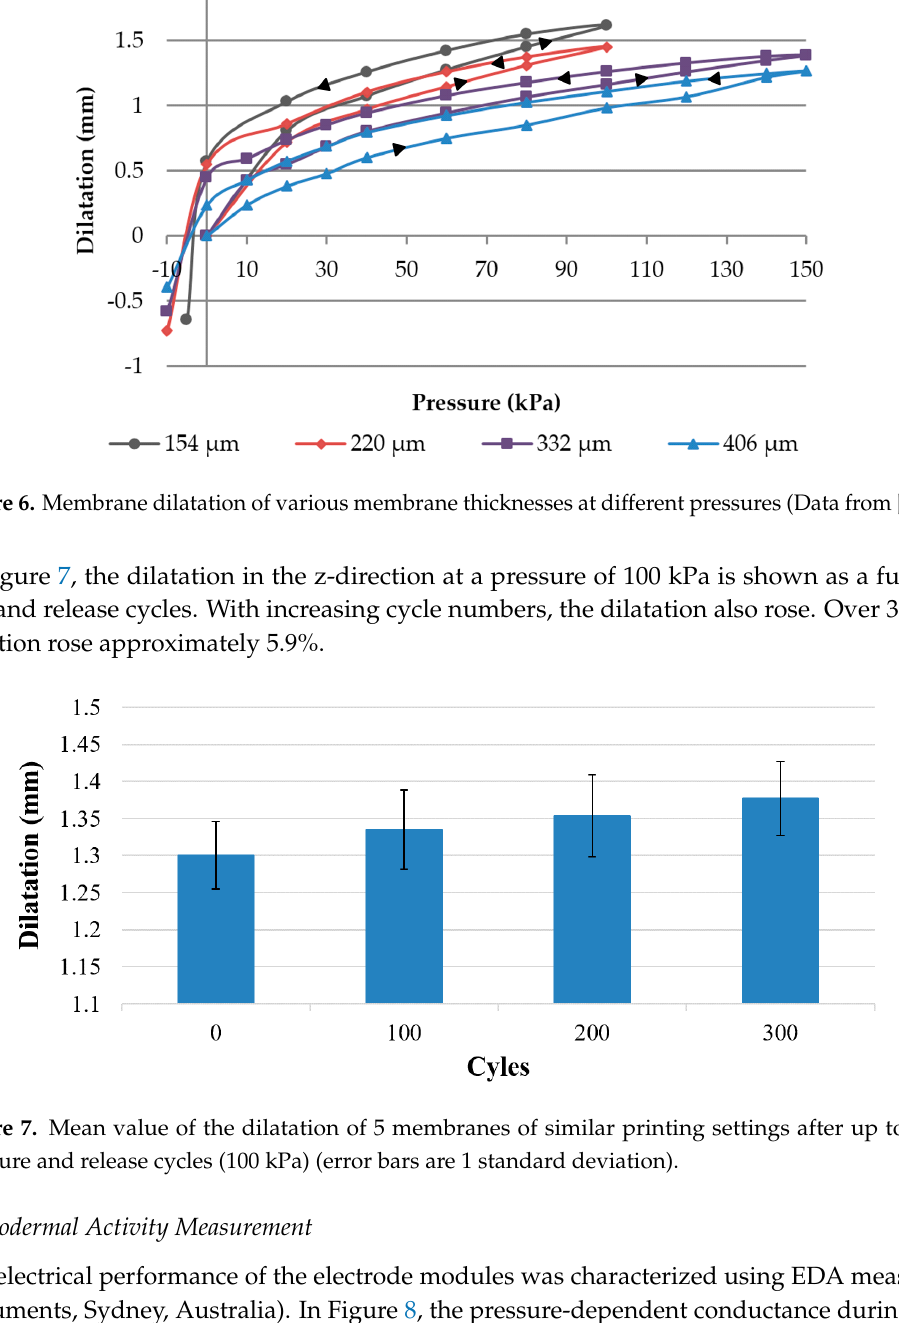
Figure 8. Pressure-dependent conductance on skin of the screen-printed electrode module on one subject (Data from [21]). Figure 9 shows the EDA measurements for each type of electrode, averaged over all 5 subjects. The finger electrode showed highest conductivity, because fingers and palms contain a higher density of sweat glands compared to the forearm, and the electrode area was the largest. Taking into account that the stainless steel electrode, with the second-largest electrode area, showed the second-highest conductivity, the achieved results are reasonable. The electrode modules both showed lower conductivity in comparison, with the screen-printed electrode being the lowest. Table 1 shows the